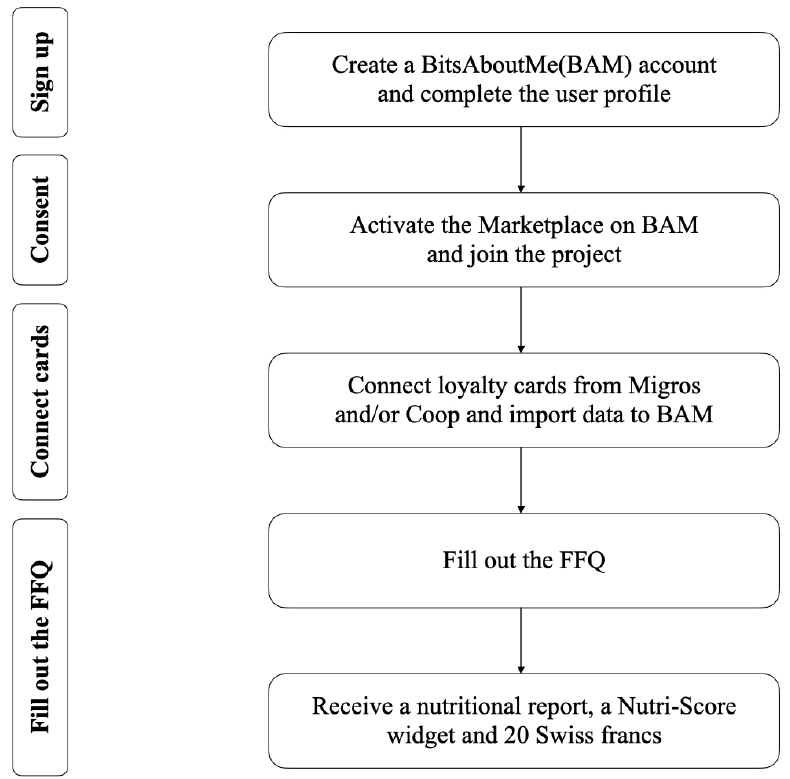
Figure 1. Participant on-boarding